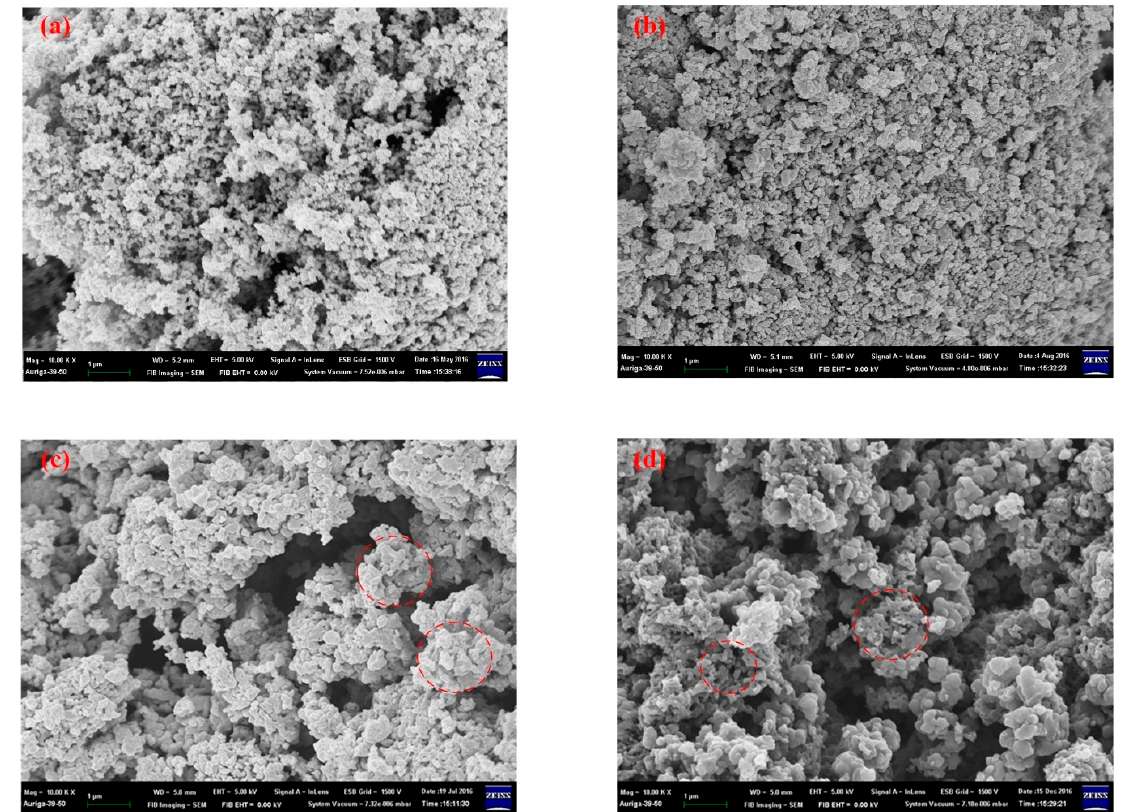
Figure 5. Scanning electronic microscopy (SEM) micropictures of ( a ) Co–C ( b ) CoNxC ( c ) CoSyC ( d ) CoNxSyC.